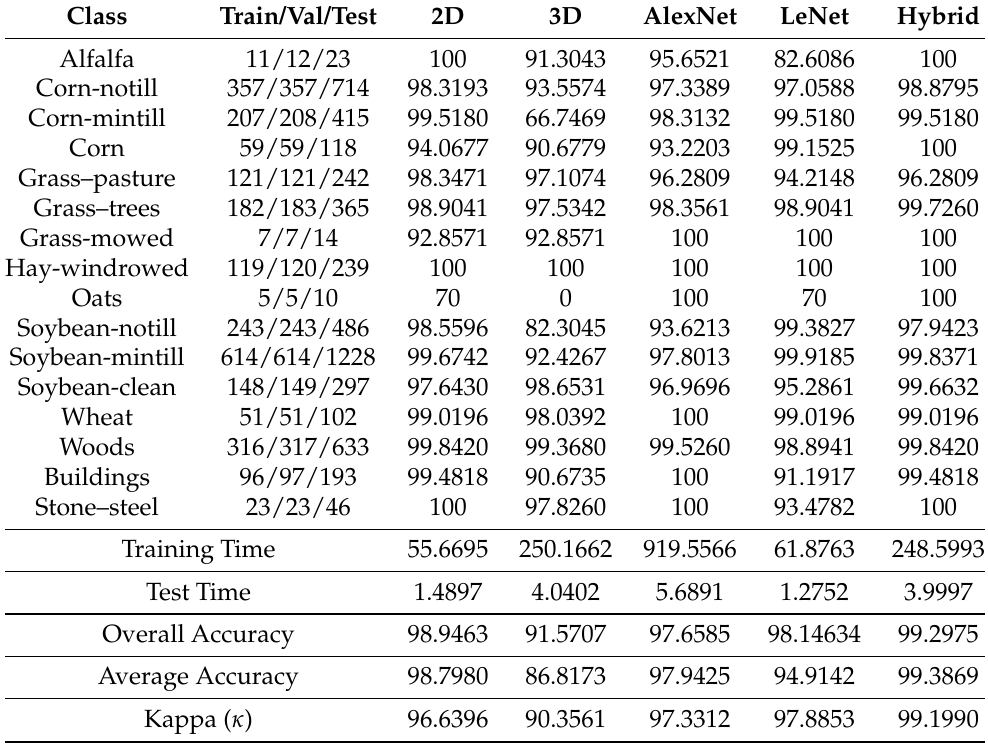
Table 1. Indian Pines: Performance analysis of different state-of-the-art models trained using regularization technique.